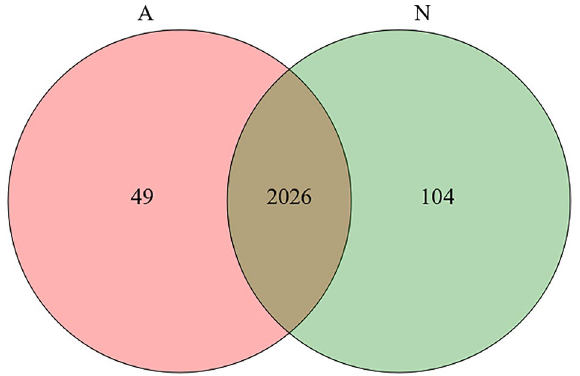
Figure 1. A Venn diagram to compare urinary proteins identified in group N and group A.